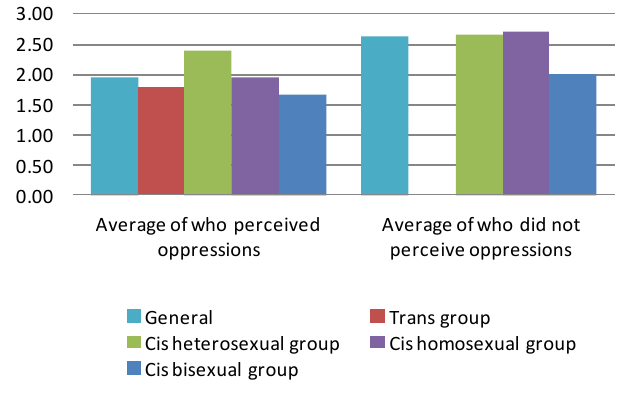
Fig. 8 – Average of grades given by each